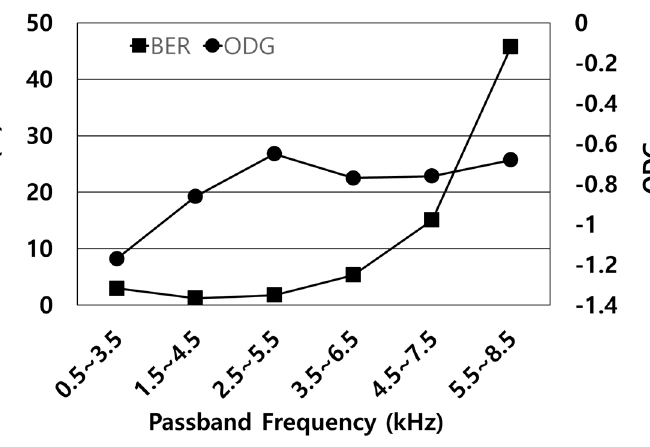
Figure 10. ODG and BER values under various passband